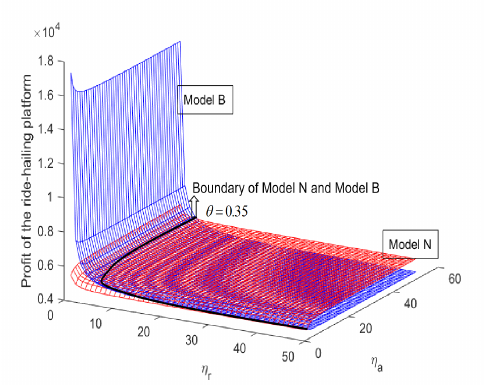
Figure 6. The sample for θ = 0.35 on η r − η a plane with π rn and π an .